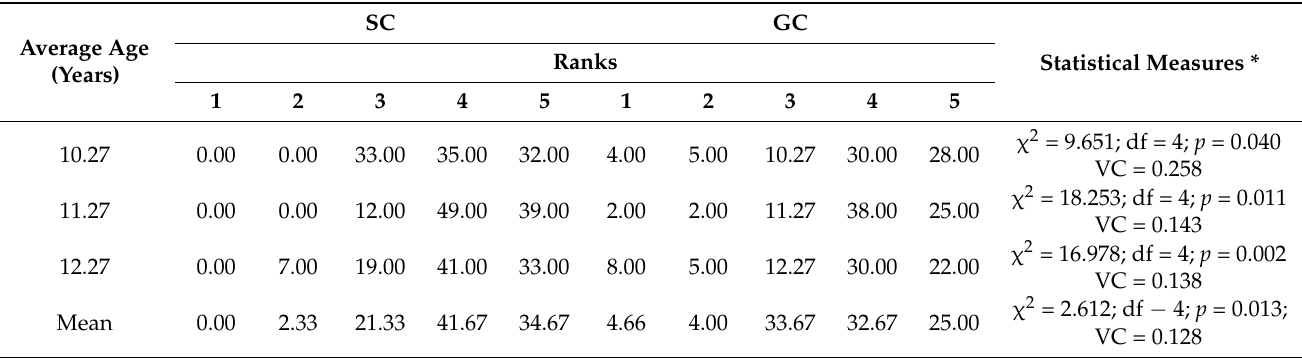
Table 5. Frequency of leisure time physical activity, % of particular ranks in the